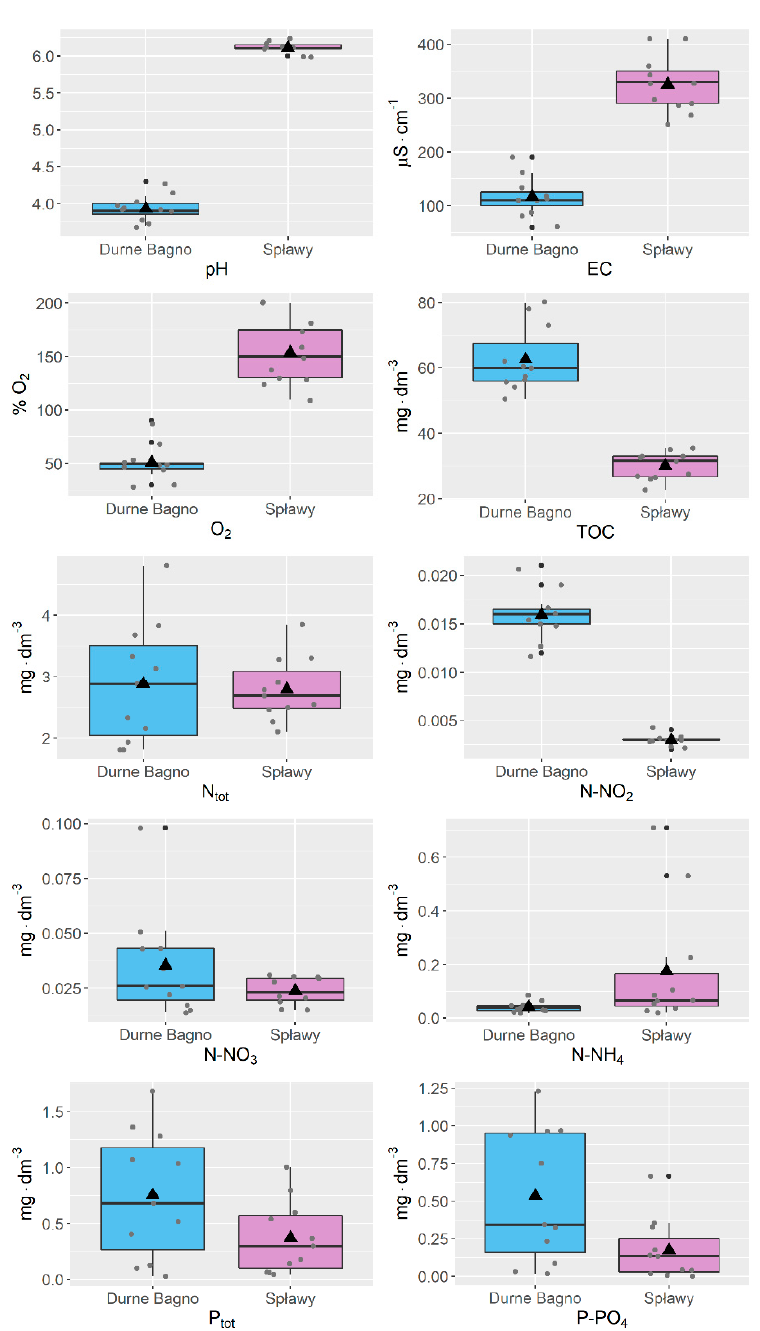
Figure 3. Distribution of physicochemical parameters at the sites of reintroduction of relict willows. Data from 11 measurements made from May to September 2021. The horizontal line across the central region of the box represents the median. The mean value of the data is marked by a filled triangle. The whiskers are drawn to the most extreme observations. Any observation not included between the whiskers is plotted as an outlier with a filled dot. The plot presents observed values of parameters, marked with small grey dots.